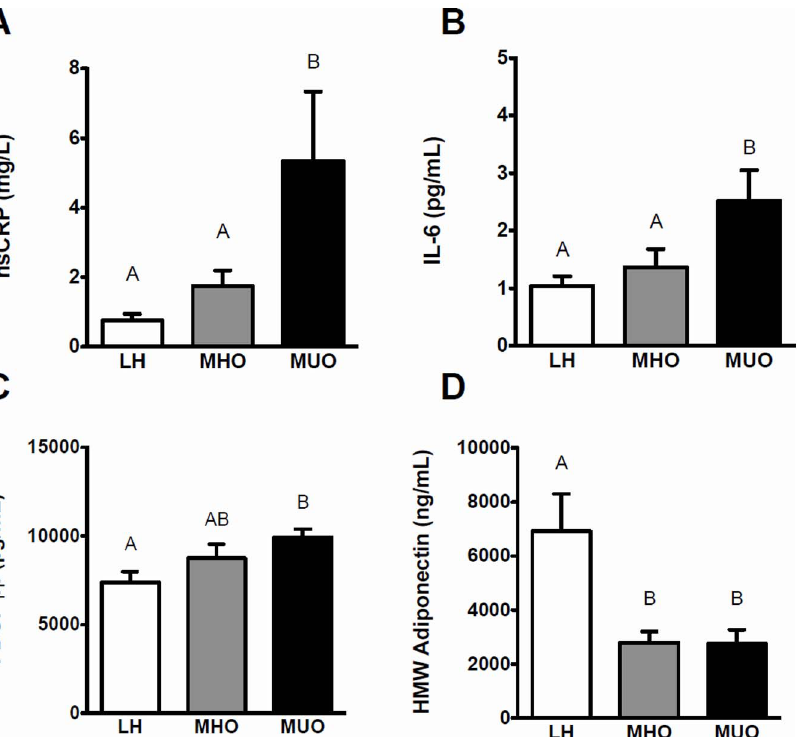
Figure 1. Comparison of mean fasting concentrations of inflammatory markers between groups. ( A ) high sensitivity C-reactive protein (hsCRP, mg/mL), ( B ) interleukin-6 (IL-6, pg/mL), ( C ) platelet-derived growth factor bb (PDGF- bb , pg/mL), and ( D ) high molecular weight adiponectin (HMW adiponectin, ng/mL) in lean healthy (LH), metabolically healthy obese (MHO) and metabolically unhealthy obese (MUO) groups (n=10/group). A non-parametric ANOVA Kruskal-Wallis test followed by a post-hoc Mann-Whitney-Wilcoxon test was used to determine differences between groups. Bars not sharing the same letter are statistically different (P , 0.05). White bars=LH; grey bars=MHO; and black bars=MUO. doi:10.1371/journal.pone.0088539.g001 PLOS ONE |